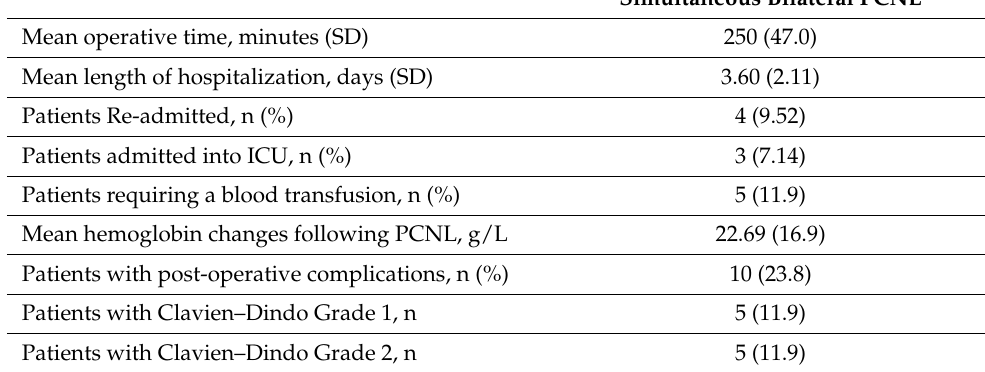
Table 2. Intraoperative data.